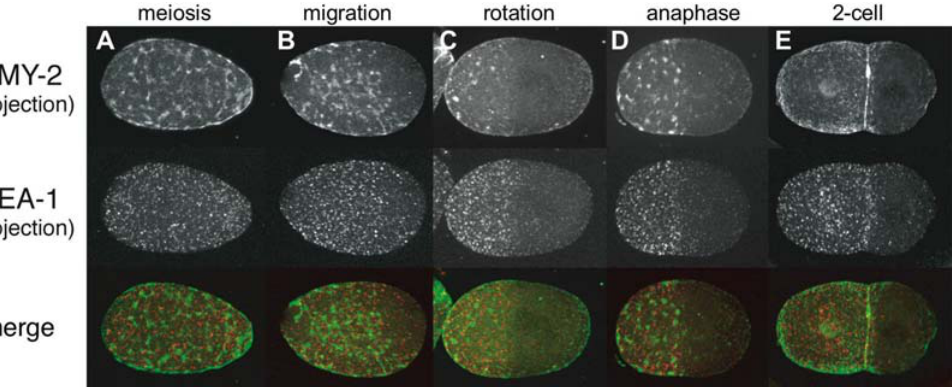
Figure 3. Asymmetry of early endosomes is coincident with NMY-2 asymmetry GFP::NMY-2 embryos co-stained for EEs (anti-EEA-1) and NMY-2 (anti-GFP). The area of enrichment of EEs coinncides with the NMY-2 domain at all stages.